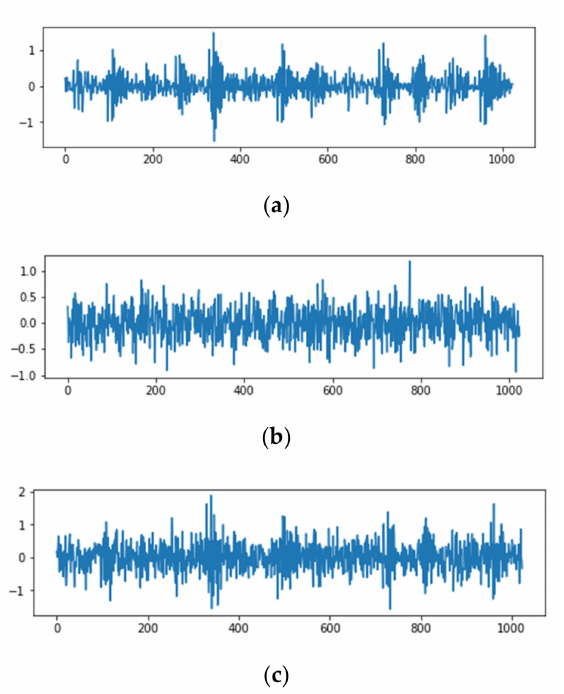
Figure 9. The original vibration signal is mixed with 1 dB of noise. ( a ) The original vibration signal. ( b ) Gaussian white noise of 1 dB. ( c ) The mixed